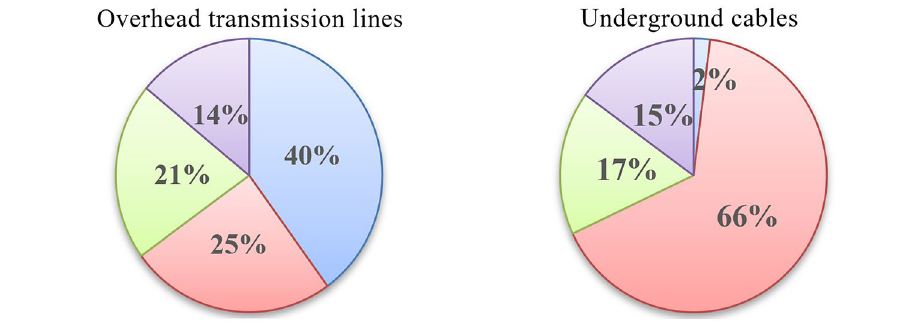
Fig. 1 Percentage ratio of power outage reasons for OTL and underground cables in PAO